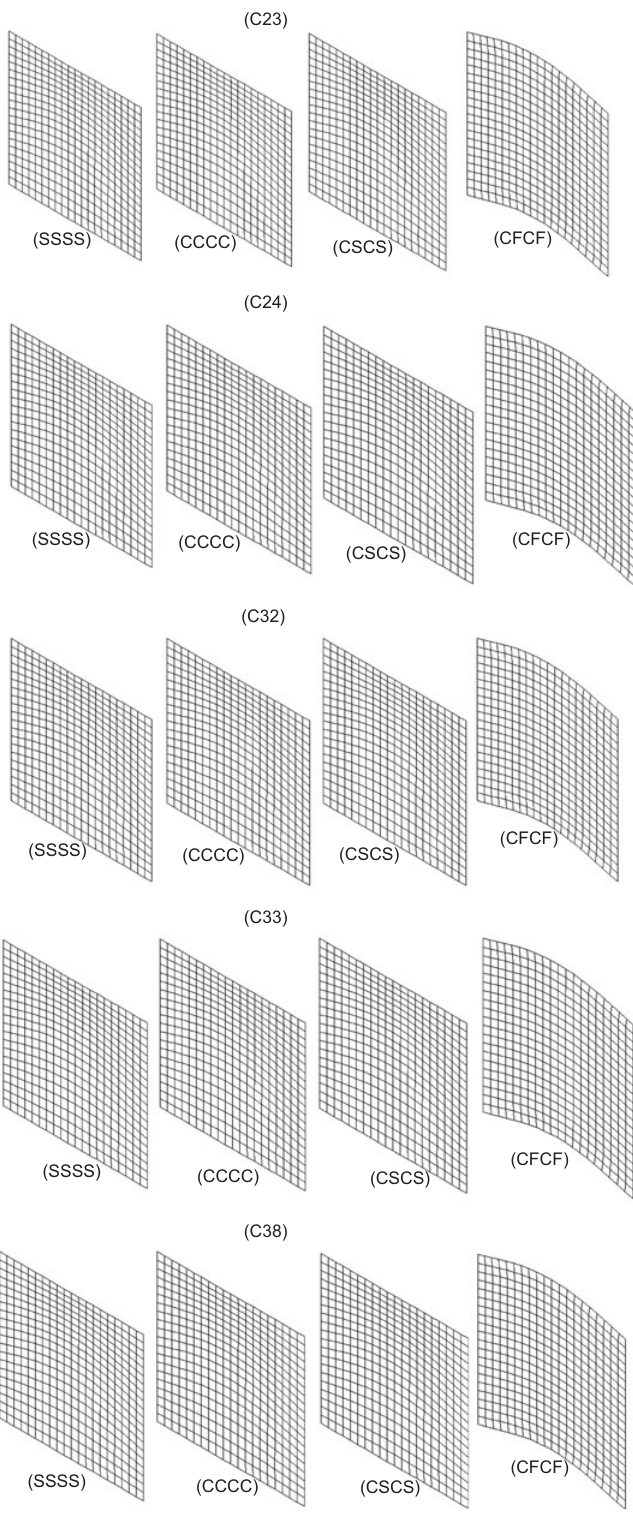
Figure 7 Mode shapes for C23, C24, C32, C33, and C38 combinations for different boundary conditions. intermediate line supports for different boundary